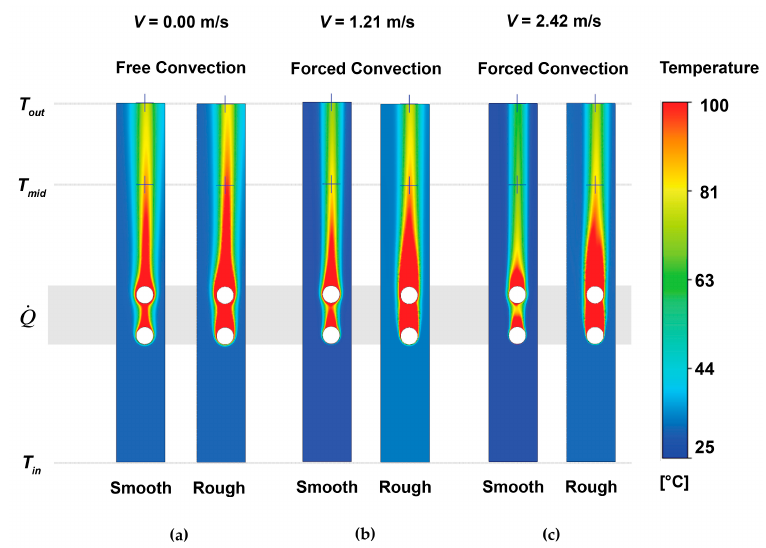
Figure 6. The temperature comparisons among the smooth and rough surfaces: ( a ) Output Temperature ( T out ); ( b ) Output Temperature ( T out ) Error; ( c ) Mid ‐ Point Temperature ( T mid ); ( d ) Mid ‐ Point Temperature ( T mid ) Error.